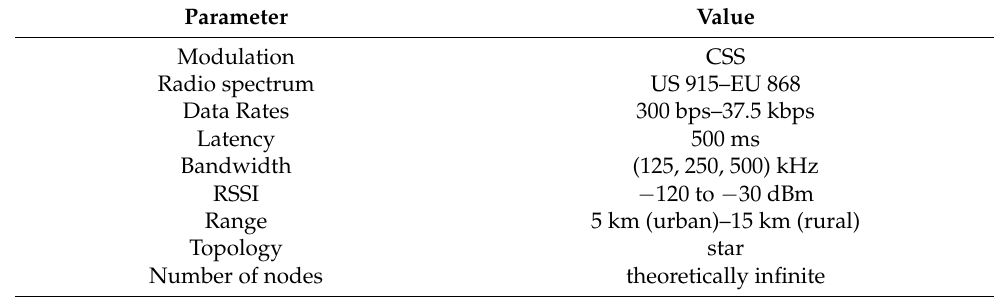
Table 1. LoRa main features.